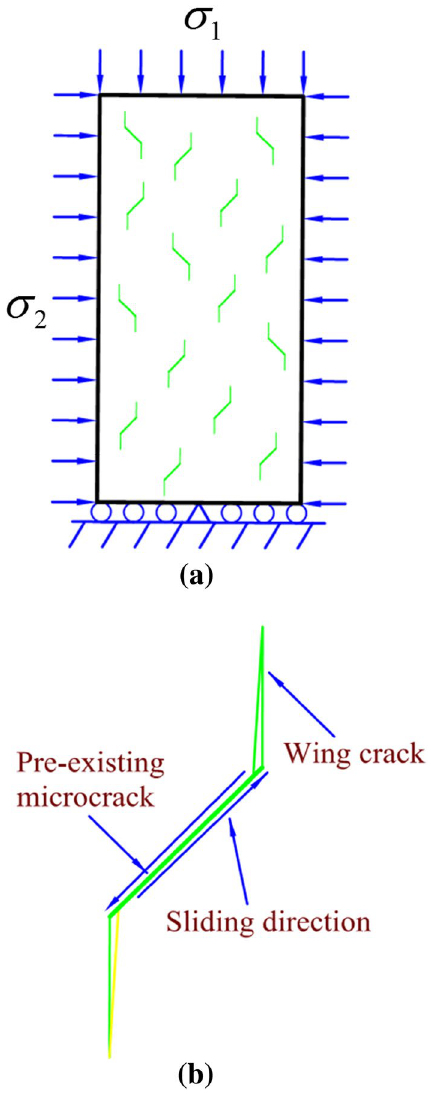
Fig. 9 Crack growth of shale samples under triaxial compression. a Pre-existing micro-cracks distribution in the shale samples ( 𝜎 1 is axial stress; 𝜎 2 is confining pressure), b Sliding crack model